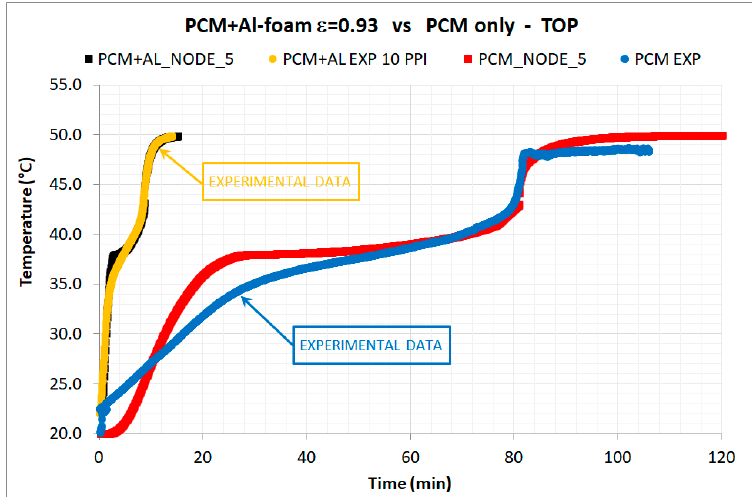
Figure 3. Simulated vs. experimental temperature profiles along the top radial section (axial node 10 at the top of the tubes) with the water temperature kept at 50 °C during the loading process of the paraffin/Al-foam composite PCM and pure paraffin wax (simulated and experimental curves).